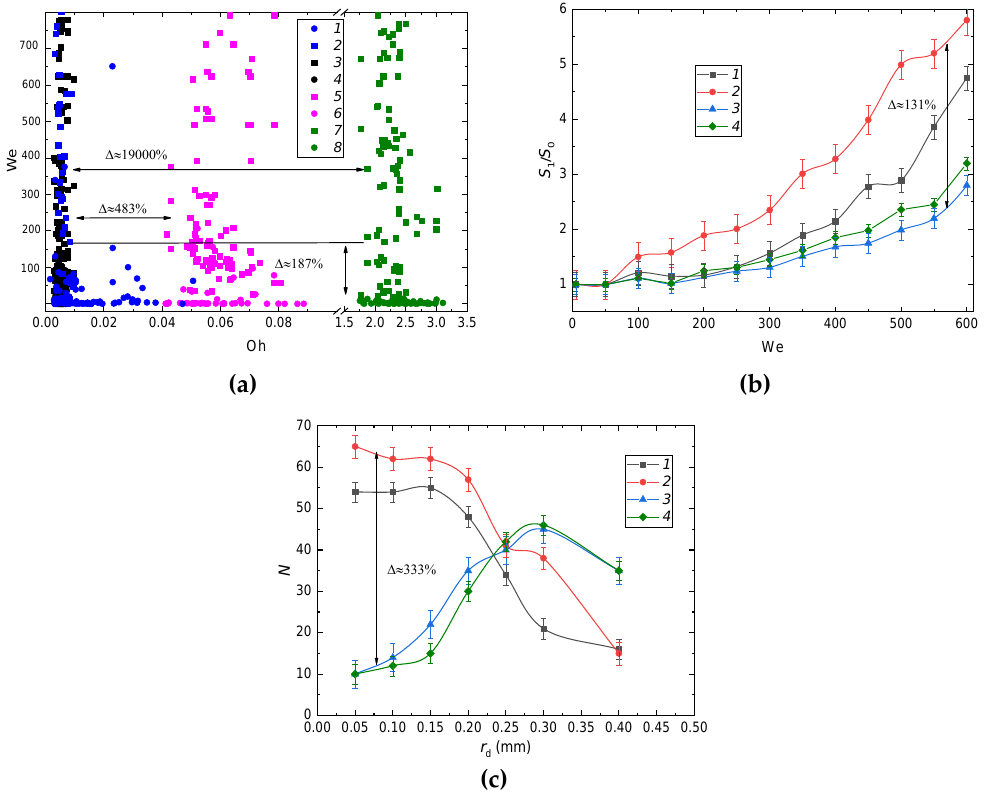
Figure 10. ( a ) Regime map of the drop impact on the wall (circle — deposition of the first drop and coalescence with all others, square — breakup) as a function of We(Oh): 1,2 — water; 3,4 — slurry (30 wt% of coal, 70 wt% of water); 5,6 — emulsion (30 vol.% of transformer oil, 70 vol.% of water); 7,8 — emulsion (30 vol.% of castor oil, 70 vol.% of water); ( b ) S 1 / S 0 (We); ( c ) size distribution of child droplets at We = 200: 1 — water; 2 — slurry (30 wt% of coal, 70 wt% of water); 3 — emulsion (30 vol.% of transformer oil, 70 vol.% of water); 4 — emulsion (30 vol.% of castor oil, 70 vol.% of water).